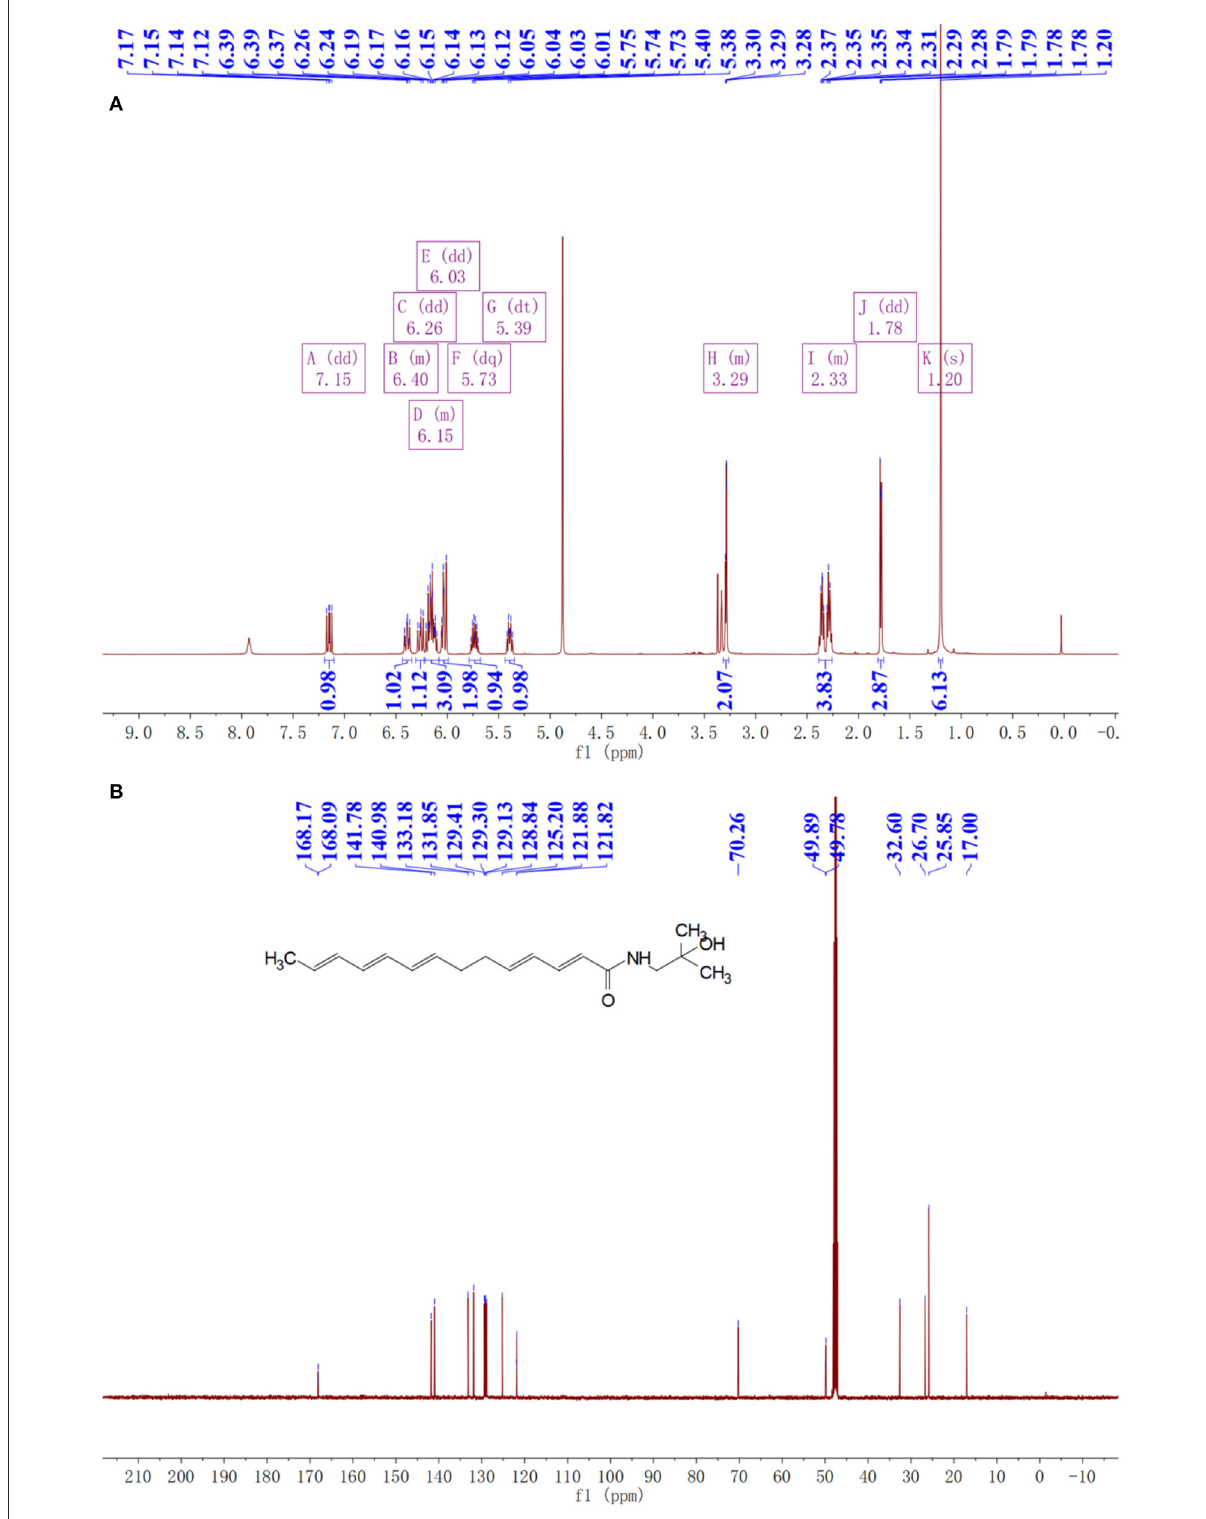
FIGURE3 NMR spectra of prepared hydroxy- γ -sanshool (HRS). (A) 1 H NMR spectra. (B) 1 C NMR